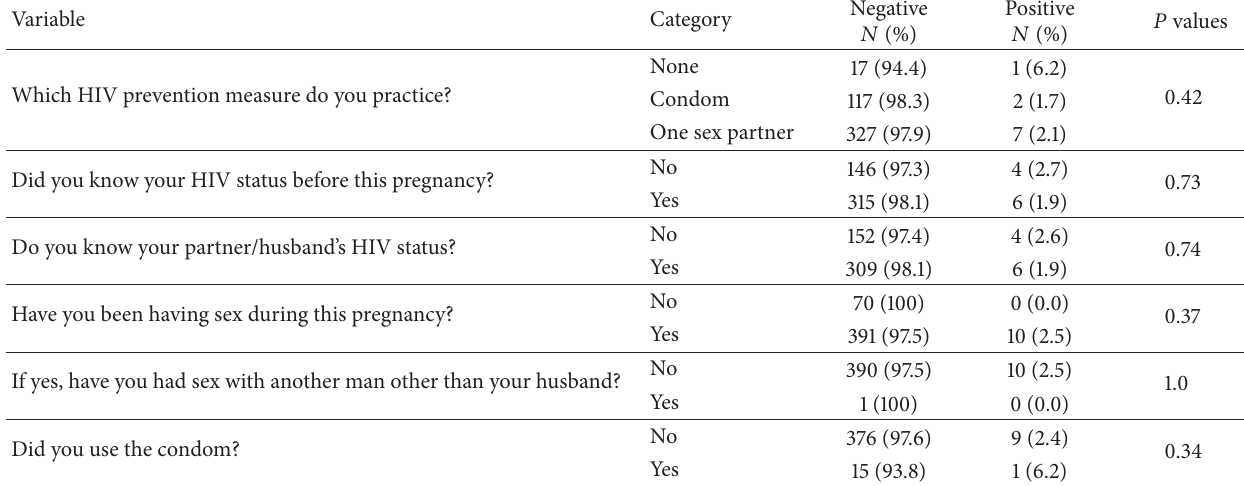
Table 7: Association between HIV prevention practices and HIV seroconversion during pregnancy in a group of 477 pregnant women in Fako Division, Cameroon. Variable